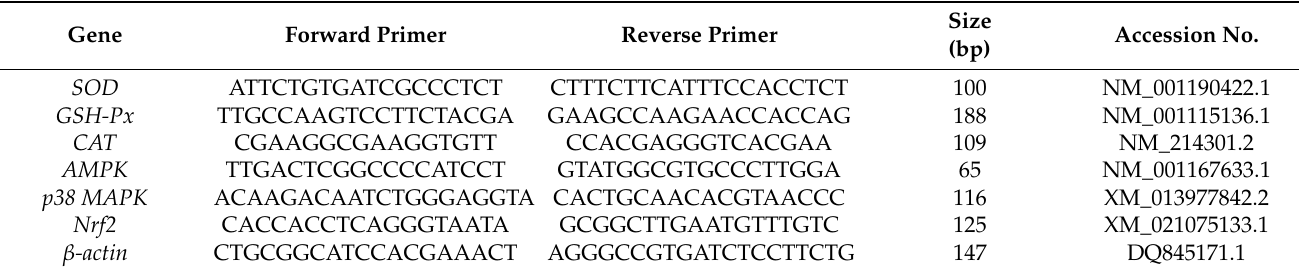
Table 2. Primers used in the present